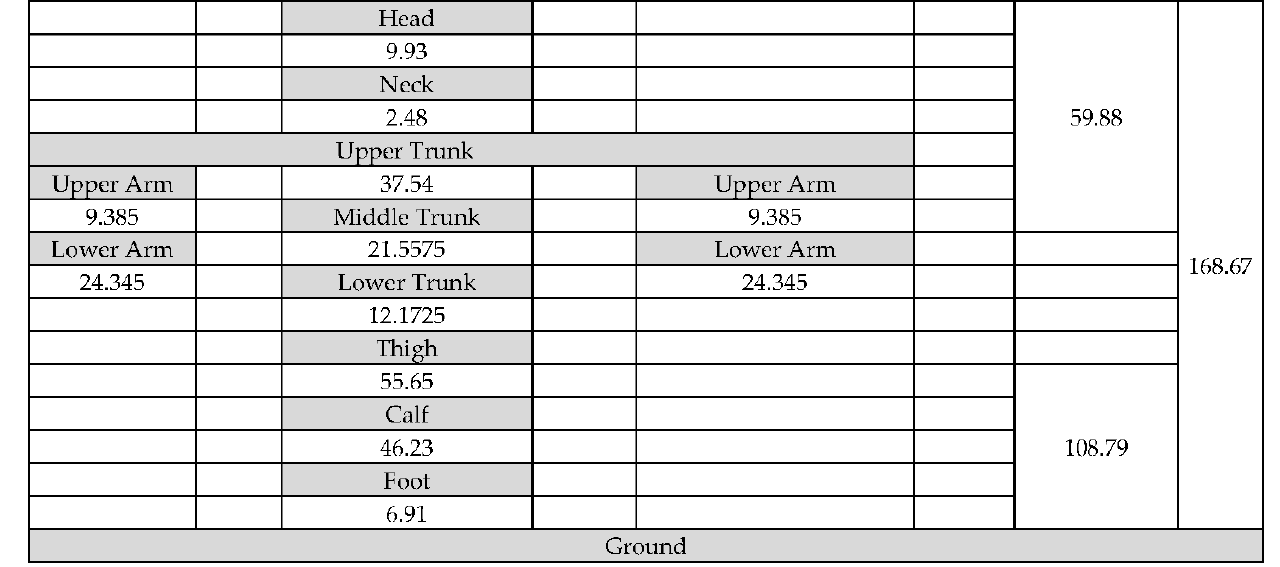
Figure A4. Locations of the center of lumped masses (CoM). Table A1. Mass of segments.